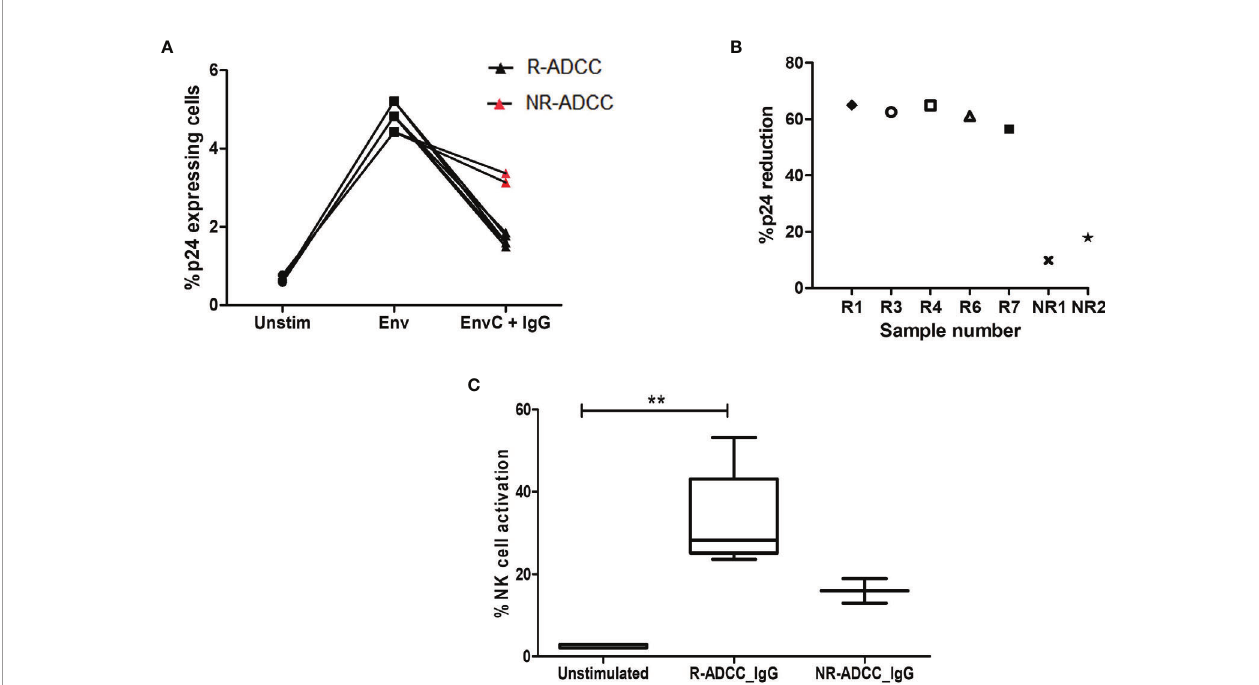
FIGURE 5 | Assessment of killing of reactivated HIV-1 latent reservoirs by the generated ADCC antibodies. (A) The line diagram shows the % p24-expressing CD4+CD45RO+ resting memory T cells ( Y -axis) in unstimulated cells, after Env C stimulation and after the addition of antibodies generated from R-ADCC LTNPs (black dots) and NR-ADCC LTNPs (red dots) to the Env-stimulated cells ( X -axis). (B) The scatter plot shows % p24 reduction ( Y -axis) in fi ve R-ADCC LTNPs (R1, R3, R4, R6, and R7) and 2 NR-ADCC LTNPs (NR1 and NR2) ( X -axis). (C) The box and whiskers plots % NK cell activation ( Y -axis) in unstimulated cells, after Env C stimulation and after the addition of antibodies generated from R- ADCC LTNPs and NR-ADCC LTNPs to the Env-stimulated cells ( X -axis). The Wilcoxon matched-pairs t -test was used to analyze the data and p ≥ 0.05 was considered to be signi fi cant. The ** represents P ≤ 0.01.